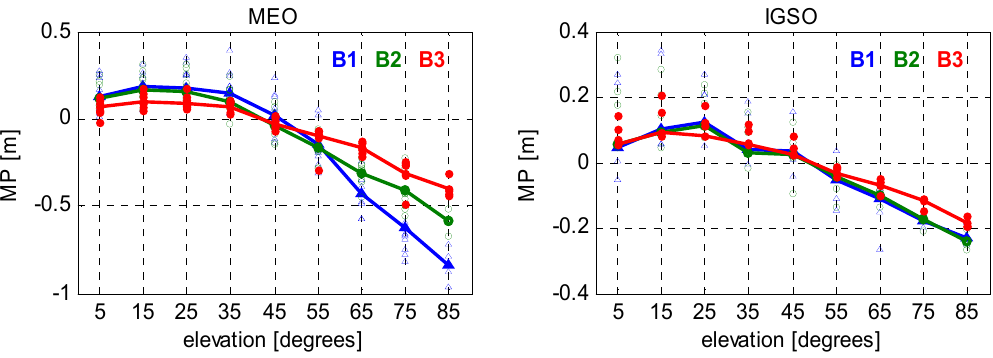
Figure 5. Piecewise linear MP models for BeiDou MEO ( left ) and IGSO satellites ( right ) using data from different stations (equipped with six Trimble receivers and four Septentrio receivers).